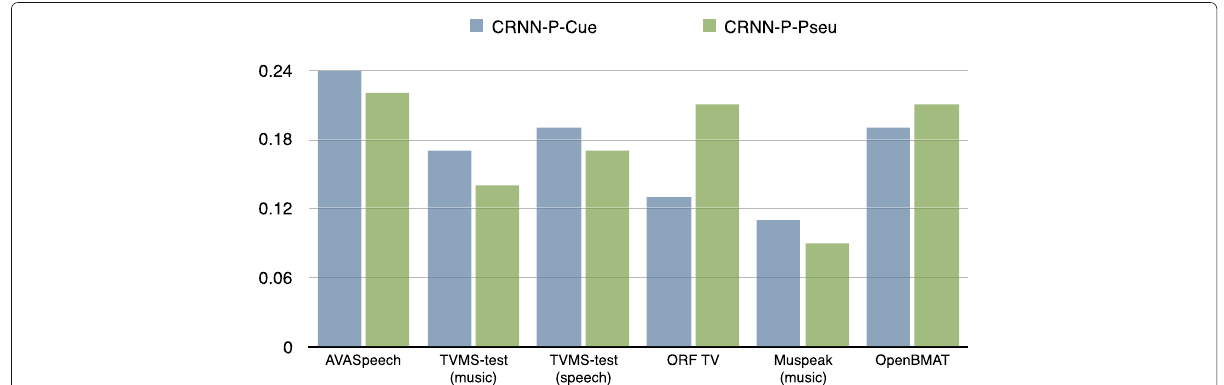
Fig. 5 The mean error rate (the lower the better) across all datasets as described in the sed_eval toolbox. The models CRNN-P-Cue and CRNN-P-Pseu are selected for comparison. TVSM-test (music) and Muspeak (music) represent the music evaluation while TVSM-test (speech) represents the speech evaluation. The other test datasets only contain either speech or music labels as described in Section 3